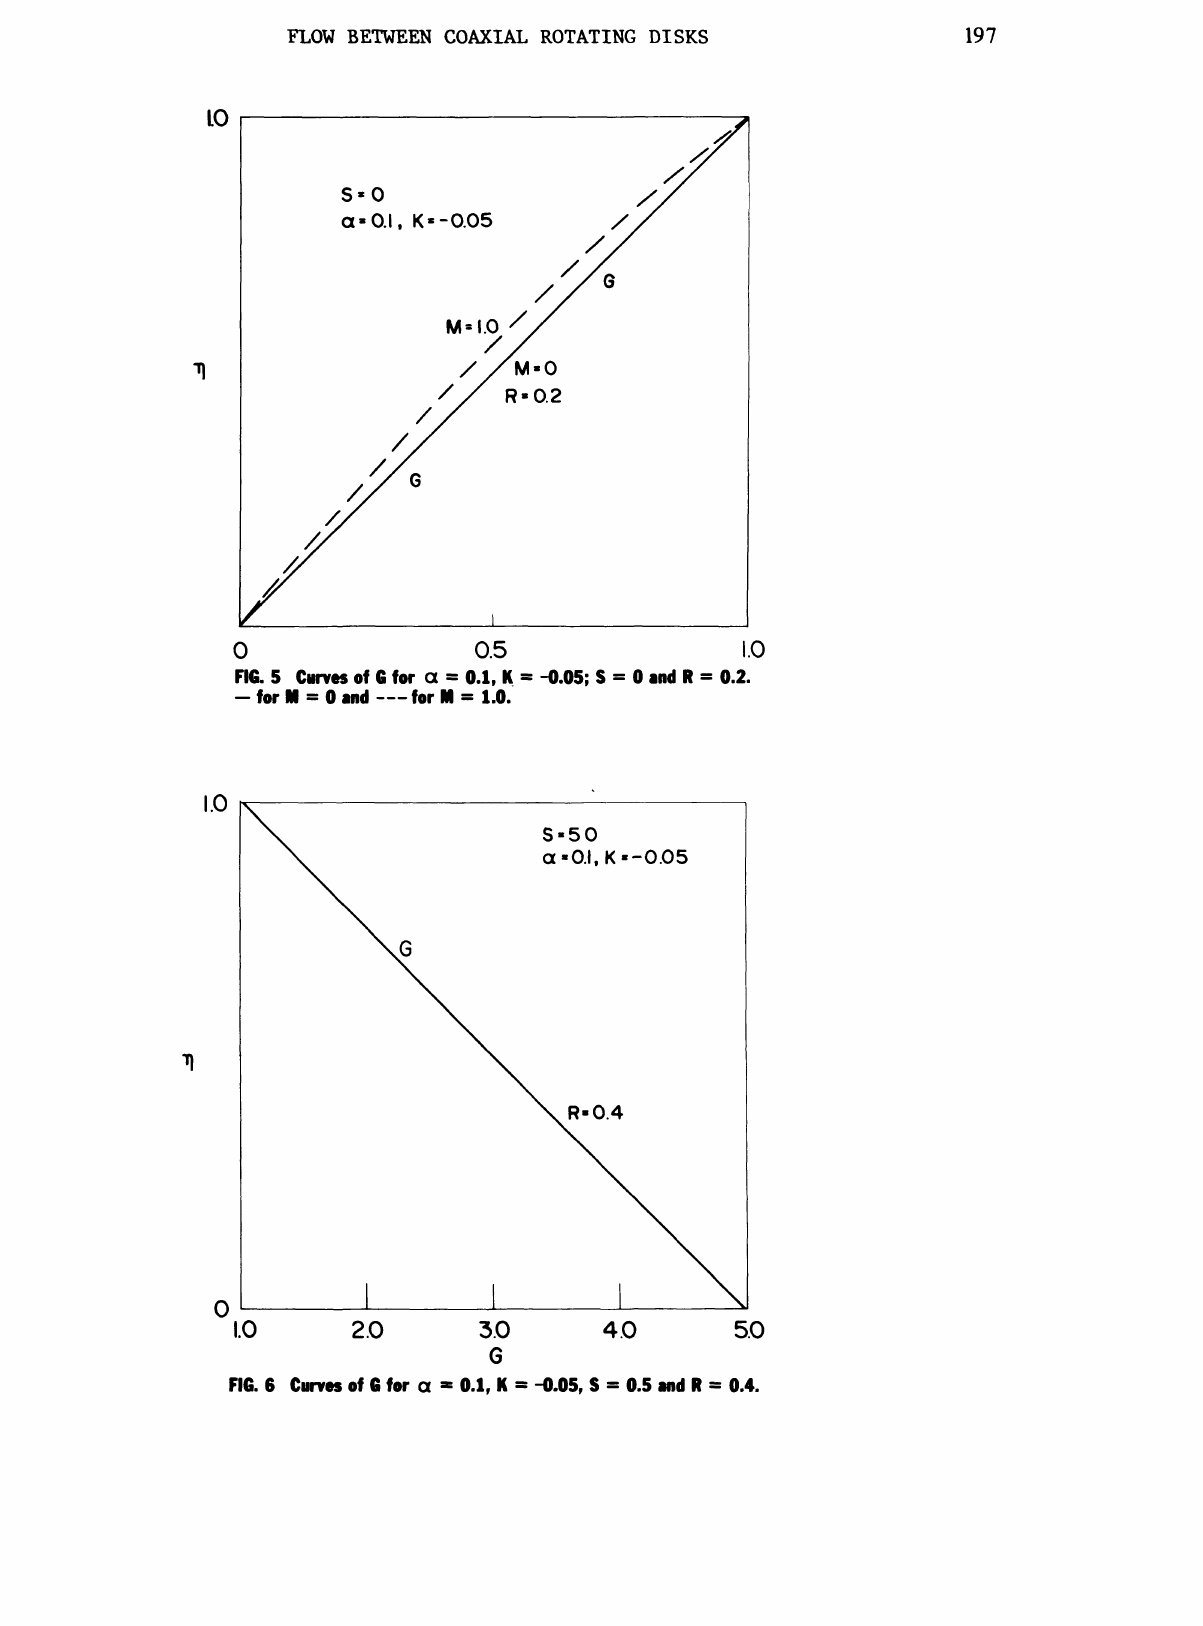
FIG. S Curves of G for